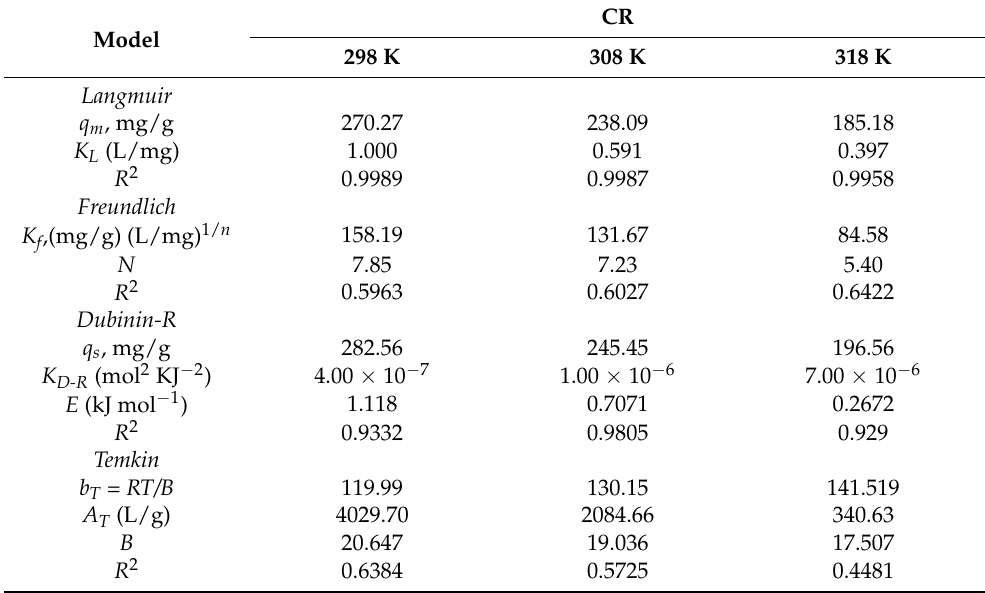
Table 2. Parameters for plotting Langmuir, Freundlich, Temkin, and Dubinin–Radushkevich adsorp- tion isotherms of CR onto CS-HAP-CeO 2